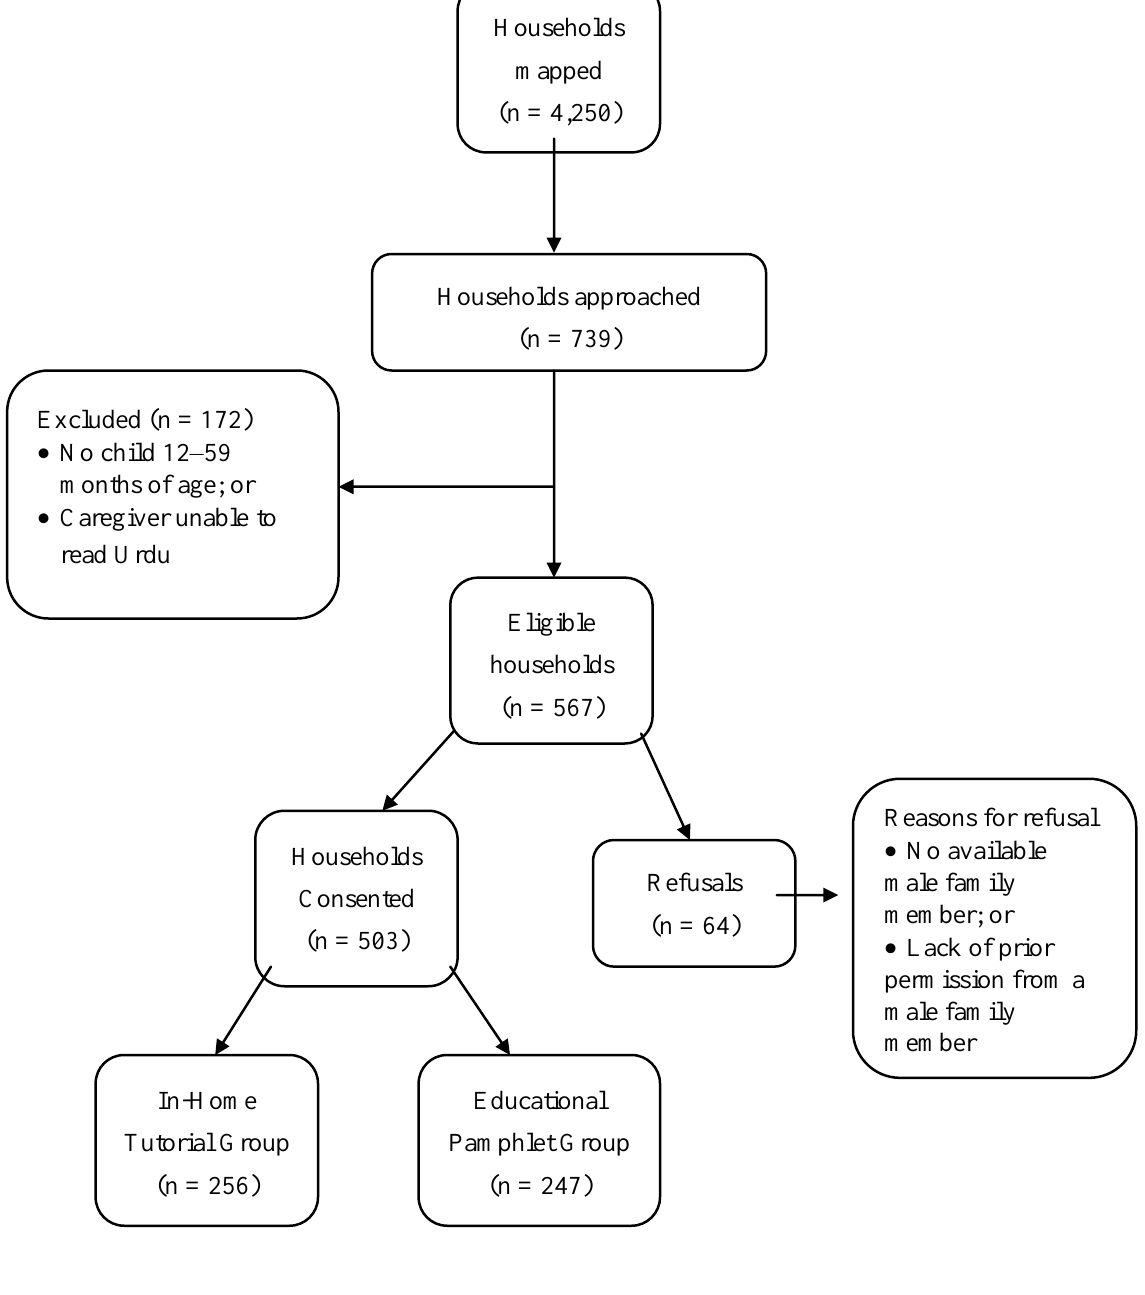
Figure 1. Flow chart of study household enrollment. Households